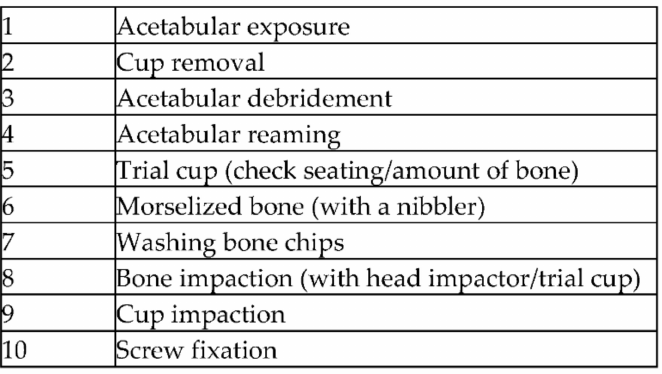
Scheme 1. Outcomes of IBG and cementless